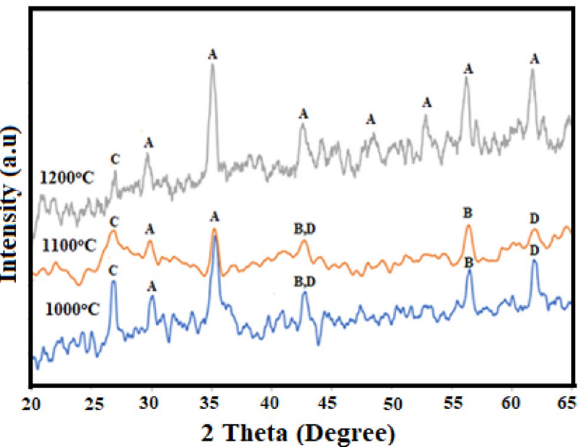
Figure 1. XRD pattern of samples at different sintering temperatures (1000, 1100 and 1200 °C) representing different phases i.e. (A) manganese ferrite (MnFe 2 O 4 ), (B) manganese oxide (MnO 2 ), (C) silicon oxide (SiO 2 ) and (D) iron oxide (FeO).